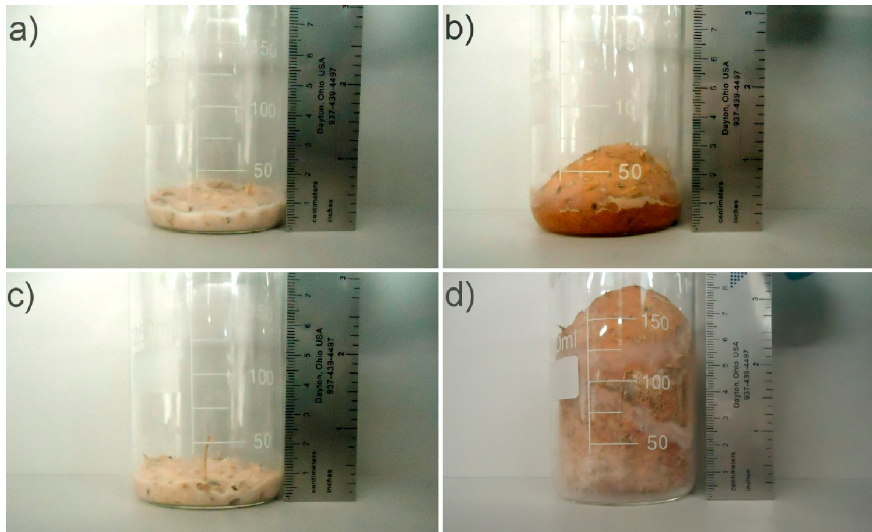
Figure 2. Expansion behavior of different types of cassava starches. ( a , b ) Native cassava starch before and after heating, respectively; ( c , d ) sour cassava starch before and after heating, respectively.